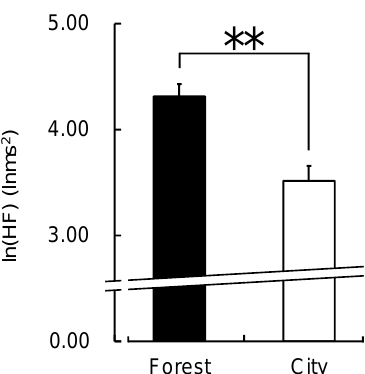
Figure 2. The natural logarithm of the high-frequency power component of heart rate variability while walking in forest and city areas. Data are shown as means ± standard error (n = 52). ** p < 0.01, paired t-test (one-sided).